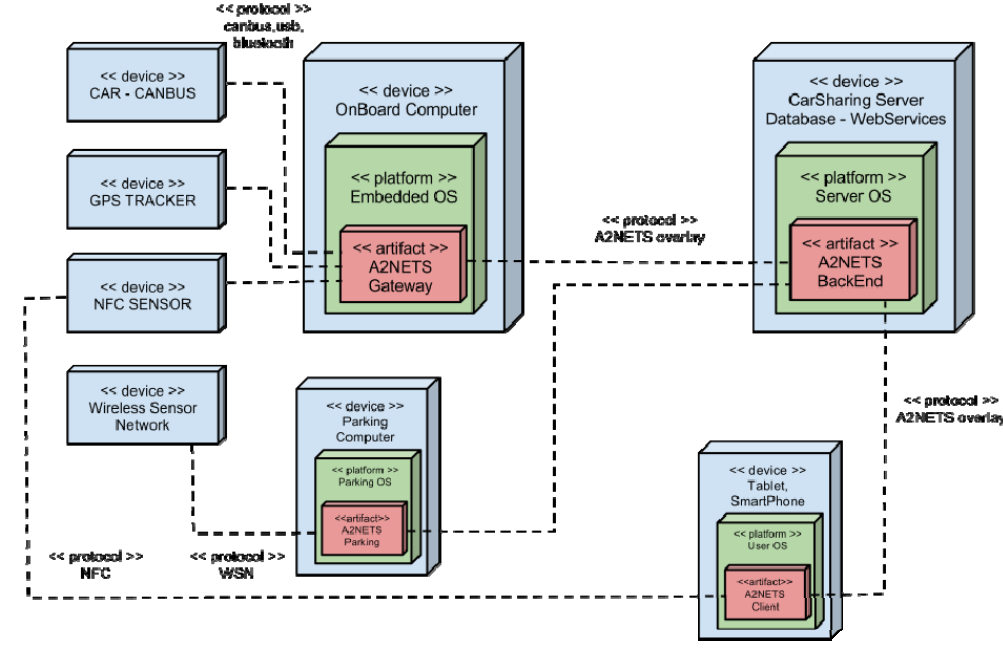
Figure 21. UMP deployment diagram of the car sharing